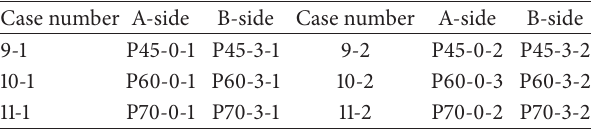
Table 2: Case design for the effect of water-cement ratio.